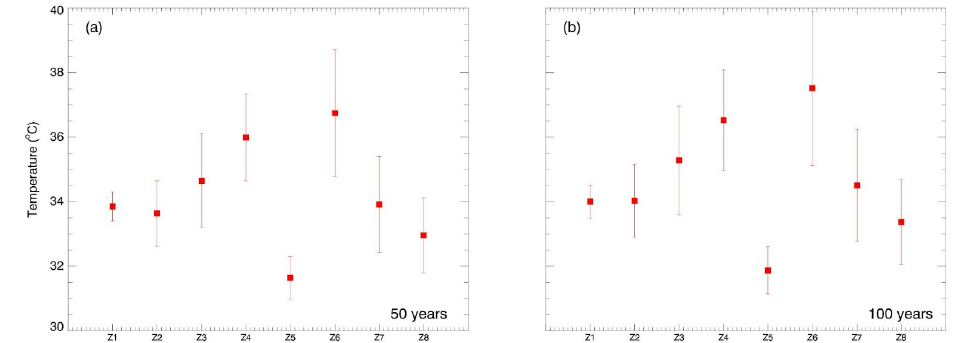
Figure 13. Return levels (daily maximum temperatures) and respective dispersion intervals for the representative stations listed in Table 1 (Z1–Z8) obtained at 50 ( a ) and 100 ( b )